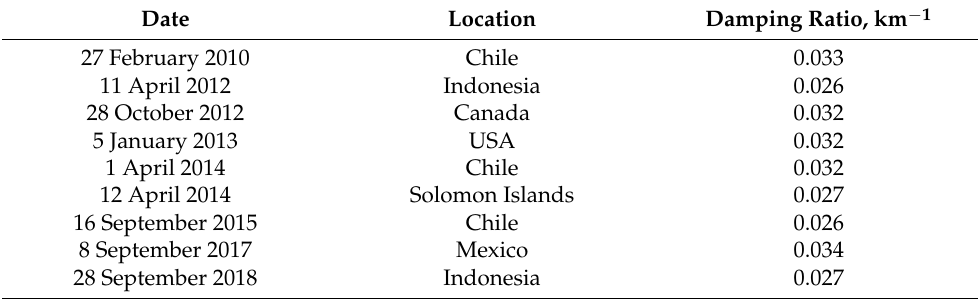
Table 2. Earthquake damping